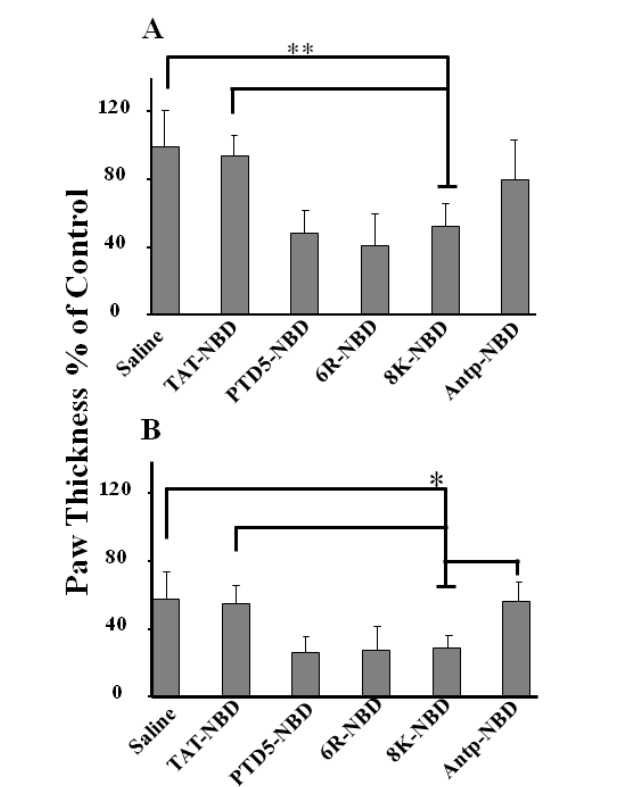
Figure 5. Local administration and in vivo efficiency of PTD-NBD peptides in reduction of paw swelling in treated paws of DTH mouse. Analysis of therapeutic efficacy of NBD peptides in murine DTH arthritis model. Fifty µL of 200 µM PTD-NBD peptides (25 µg/paw) was injected in to right paw 2 h before antigen administration. Mice were monitored for paw thickness at 48 (a) and 72 h (b) after antigen administration ( n = 10). Results were expressed as the percentage of control paw swelling. ** P < 0.001; * P <